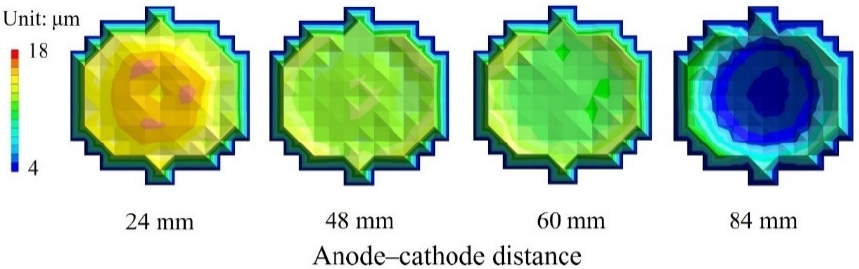
Figure 4. Substrate in-plane-coating thickness distribution. The average film thickness is 12.3 µm and σ = 0.72 µm, with a 60 mm inter-electrode distance, and at 48 mm, the variation is minimized, with an average film thickness of 12.9 µm and σ = 0.49 µm. There is almost no difference in the substrate in-plane film thickness with a 48 mm inter-electrode distance, and the variation is the smallest in this case.